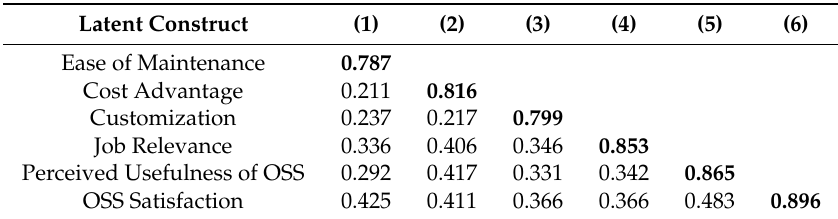
Table 6. Discriminant validity